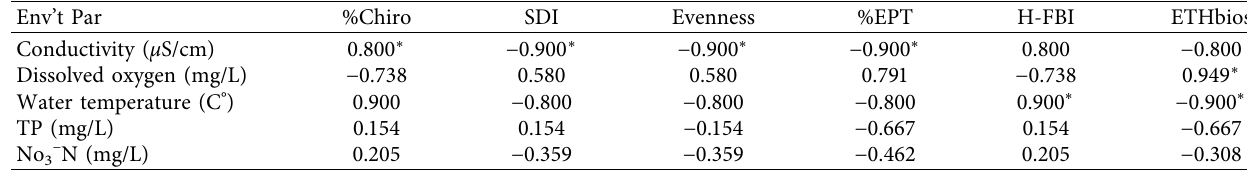
Table 4: Bivariate Spearman correlation between benthic macroinvertebrates indices and some physicochemical